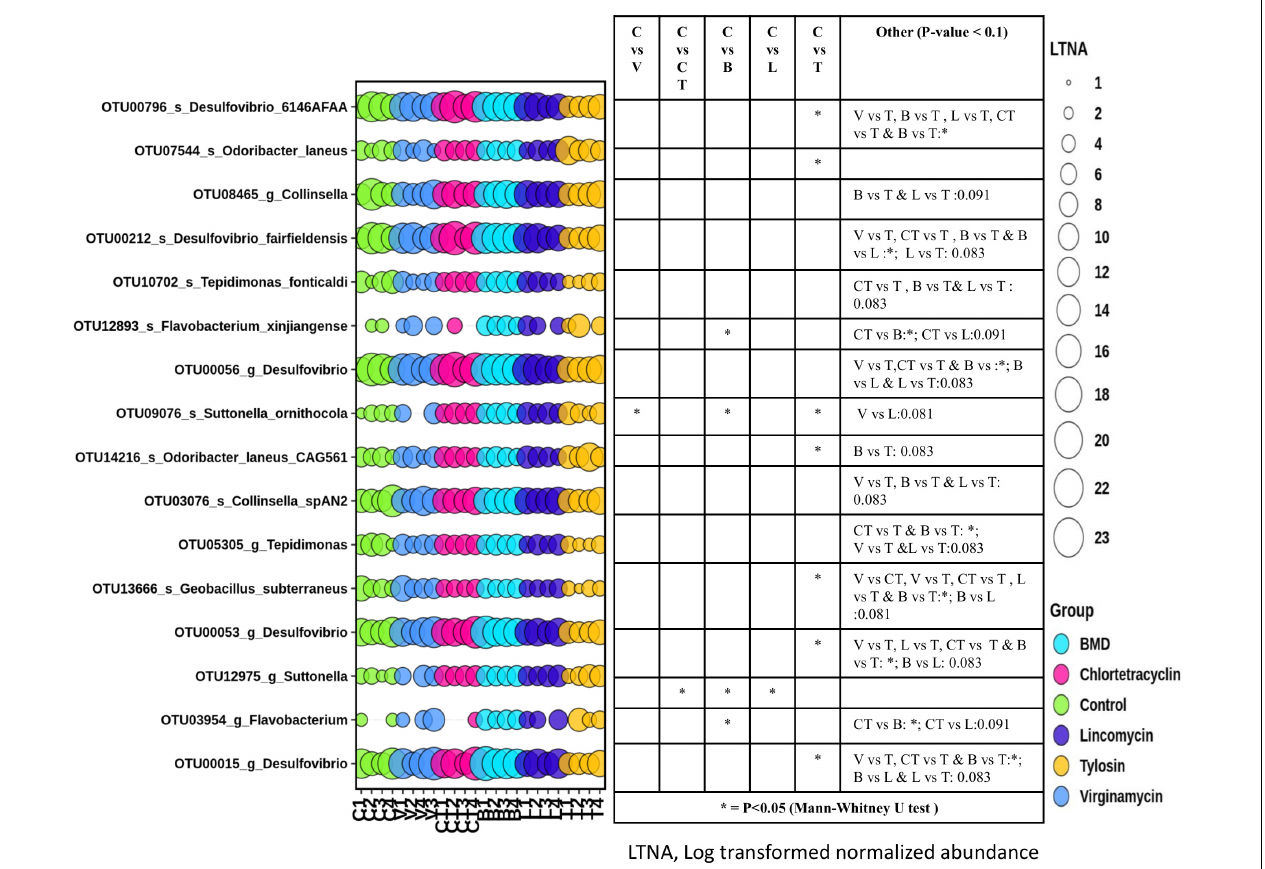
FIGURE 5 | Differential abundance of gut microbiota in different groups at OTU level. OTUs with significant difference in abundance among groups identified with DESeq2 and passing false discovery rate (FDR) filter, were plotted. The size of the bubbles in the bubble plot indicates the log- transformed (LN(2)) normalized (cumulative sum scaling) abundance of each